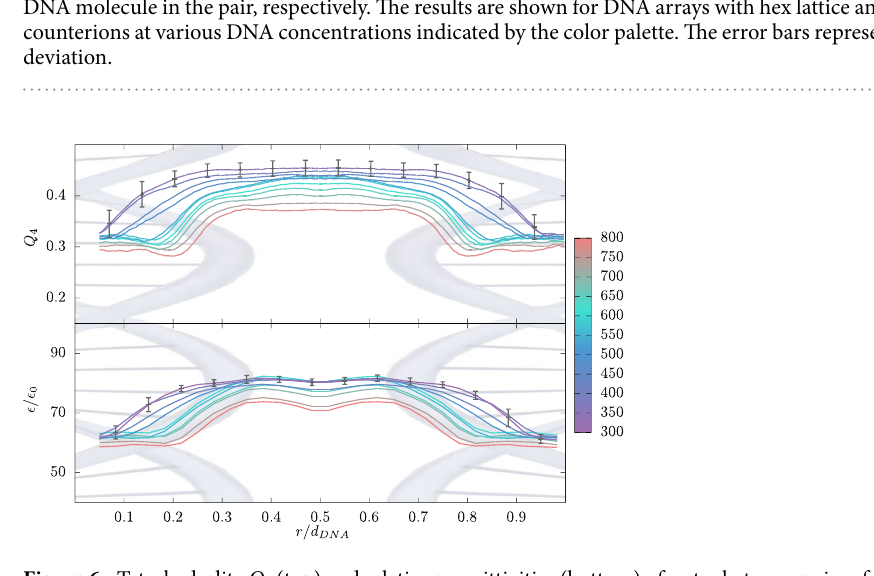
Figure 6. Tetrahedrality Q 4 (top) and relative permittivities (bottom) of water between pairs of neighboring DNA molecules. The results are shown for DNA assemblies in the hex lattice and Na + as counterions, at various DNA concentrations. The symbols are the same as in Fig.